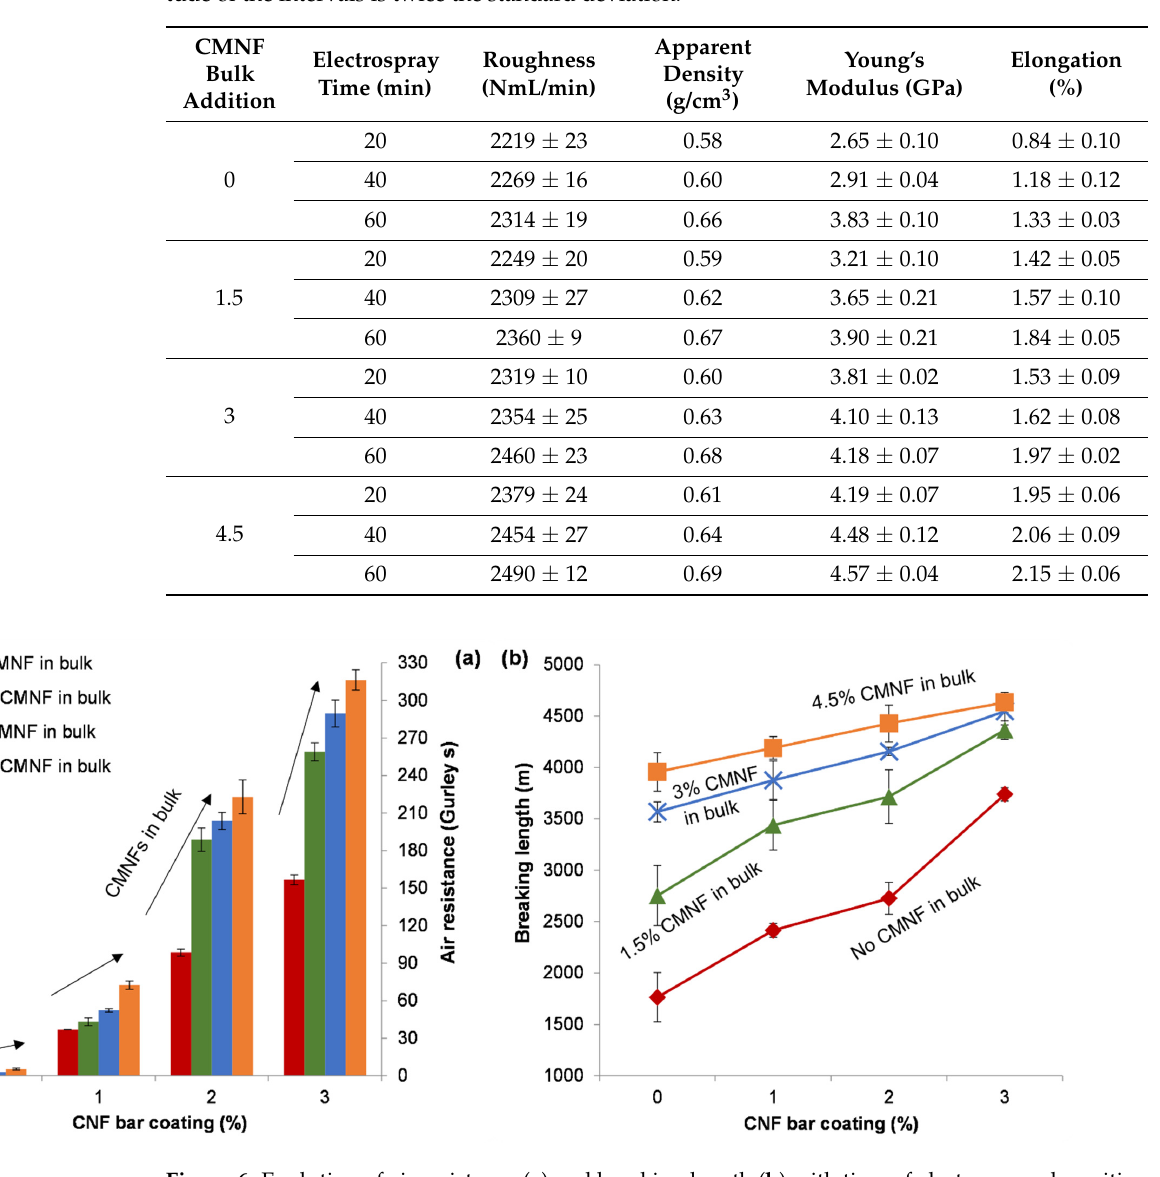
Figure 6. Evolution of air resistance ( a ) and breaking length ( b ) with time of electrospray deposition from a dispersion of oxycellulose nanofibers, for the four levels of CMNF in-bulk content. Error bars correspond to twice the standard deviation.